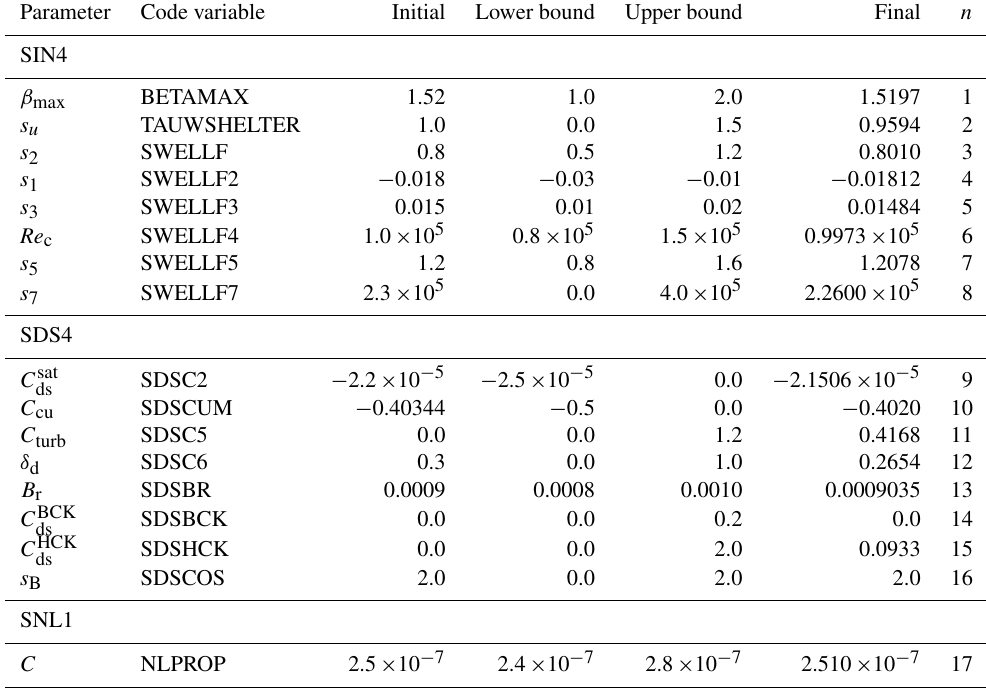
Table 3. As for Table 2 but for parameters used to calibrate the simulation using the source term package of Ardhuin et al. (2010), for February through April 1997. The namelist groupings in bold correspond to parameterisations related to wind input (SIN4), dissipation (SDS4), nonlinear interactions (SNL1) and some “miscellaneous” parameters (MISC). Lower and upper bounds are specified for parameters adjusted during calibration, along with their final values, and the corresponding index n of the normalised parameter vector, as used to label plots in Fig.